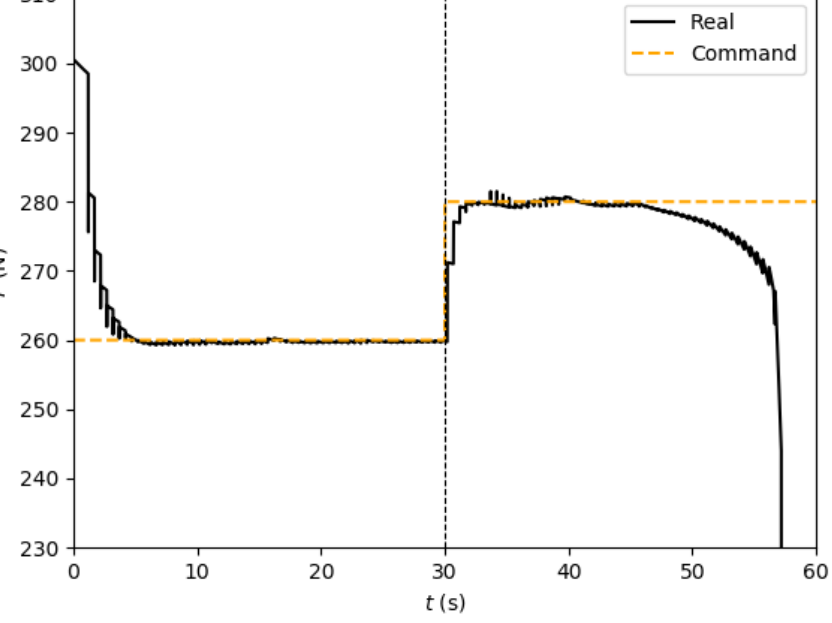
Figure 21. Thrust profile, feedback with complete regulation law, case